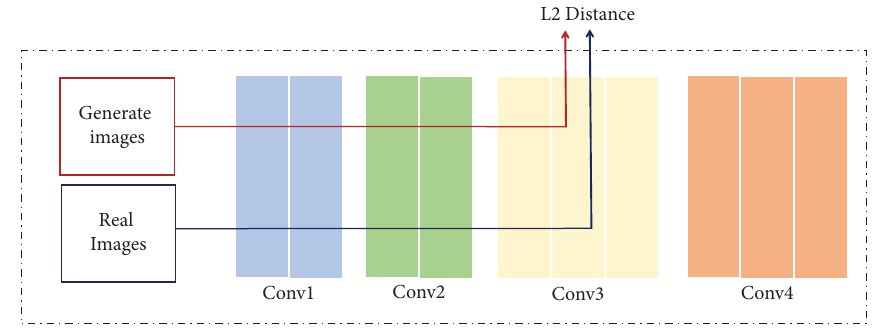
Figure 3: Feature perception loss calculation.